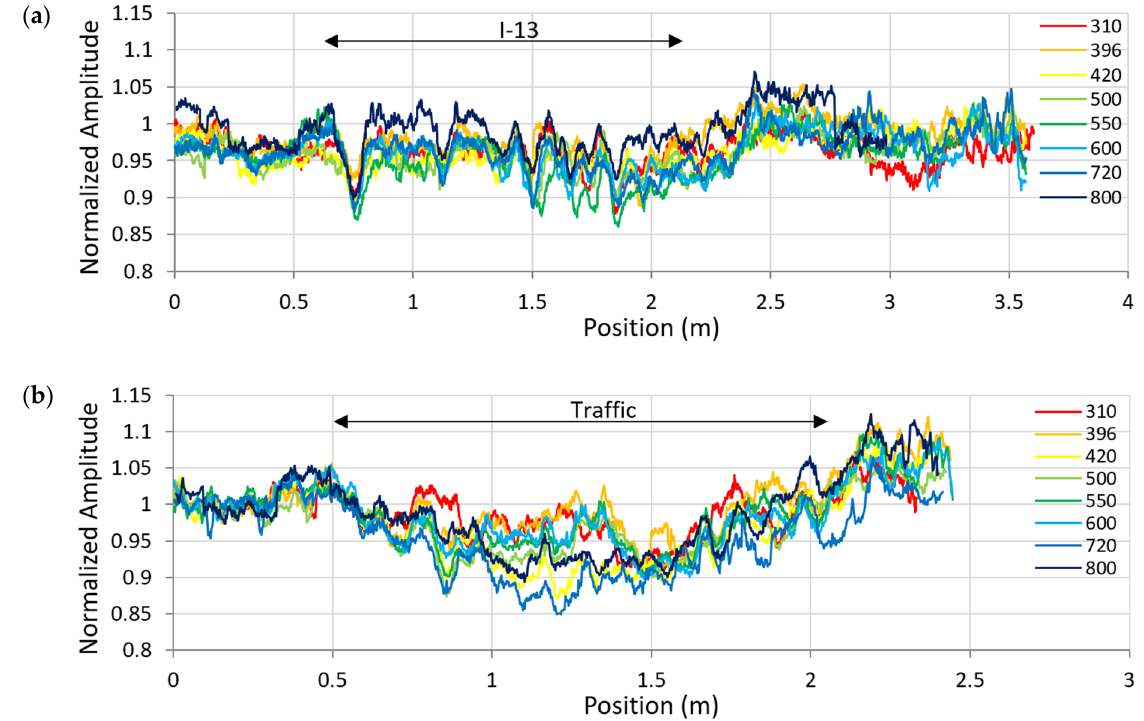
Figure 24. 2.6 GHz Normalized DW amplitudes on tack-coat free (I-13) in the ( a ) long. and ( b ) transv. direction vs. K loadings.